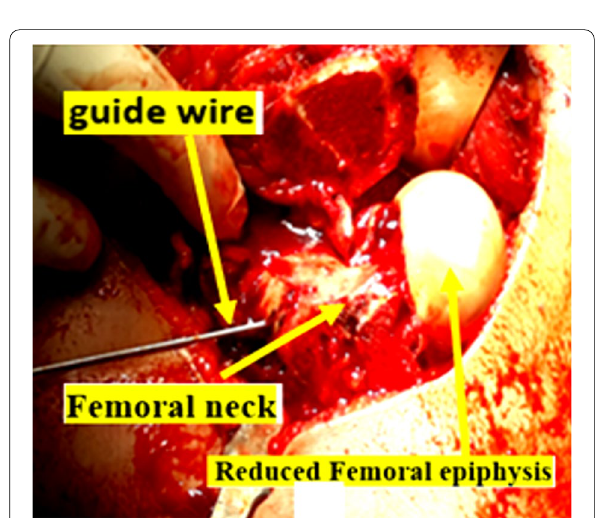
Fig. 5 Reduction and provisional fixation of the